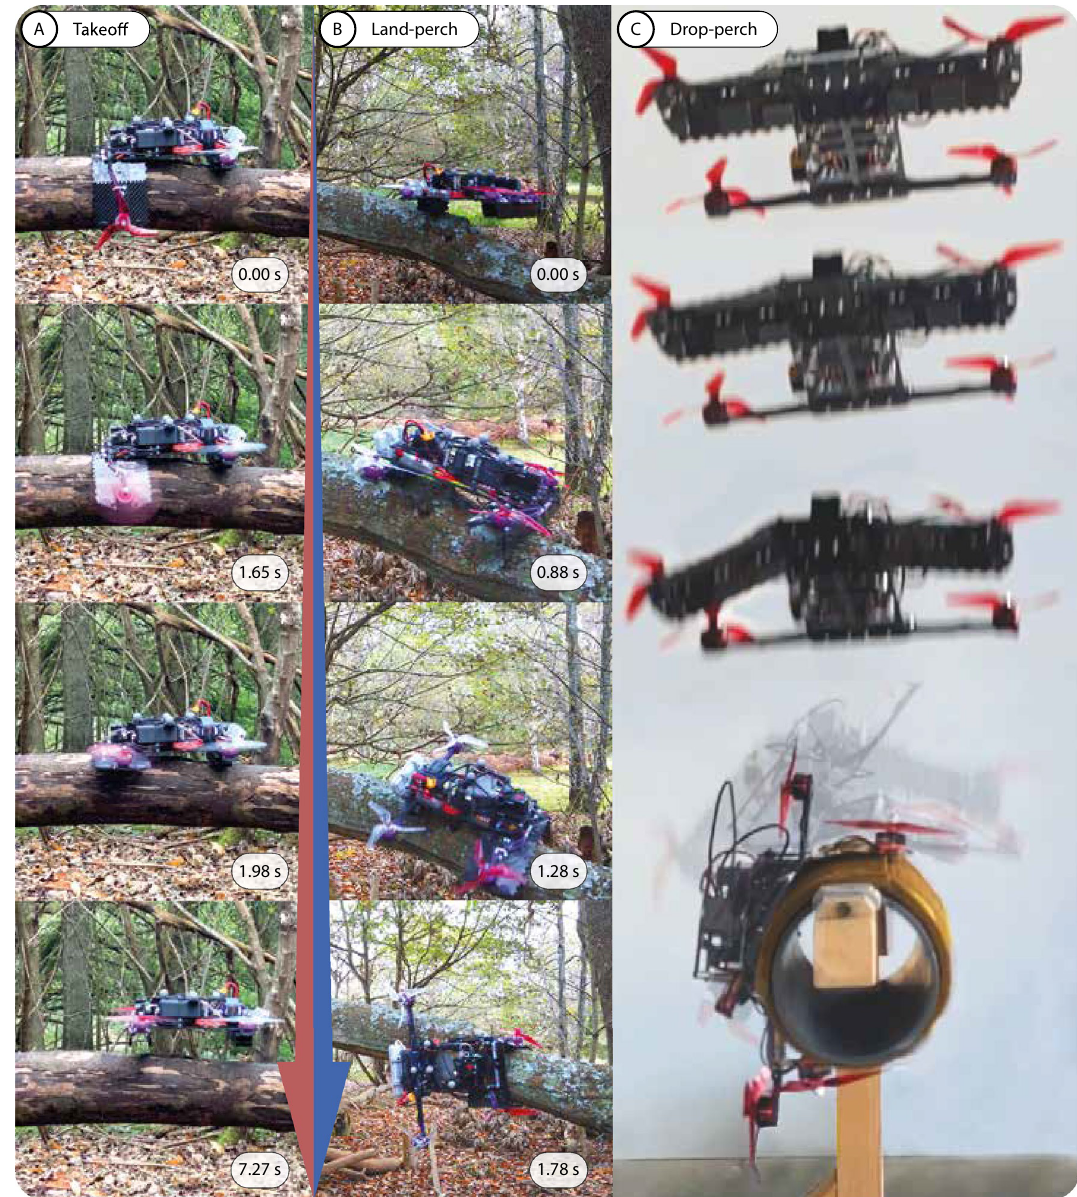
Figure 6. The morphing robot perching indoors and outdoors. ( A ) The robot manually taking off from a perch on a smooth bark tree. ( B ) The robot performing a manual land-perch. ( C ) The robot performing an autonomous drop-perch use motion capture odometry. The robot bounced slightly upon impact, it then firmly gripped onto the side of the fibrous pad covered artificial branch, diameter 140